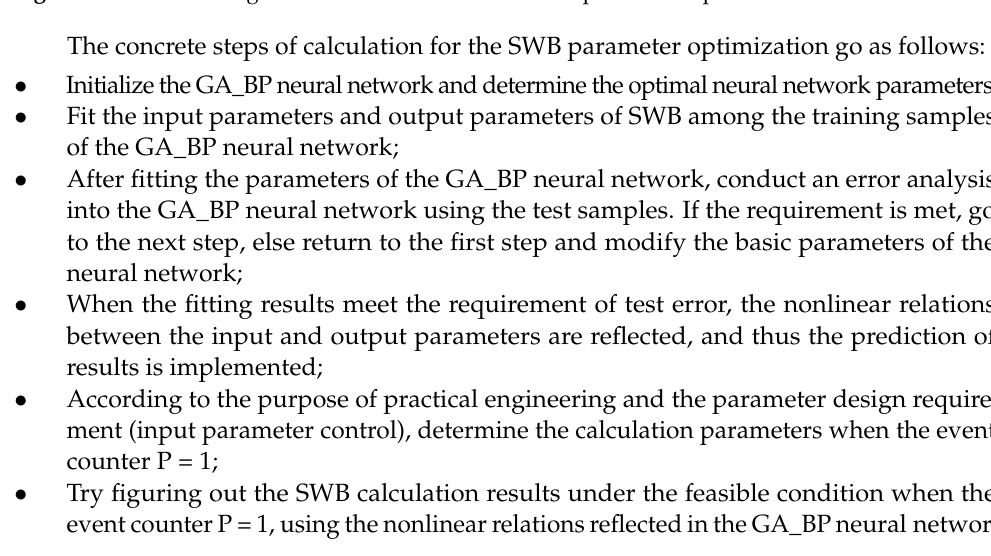
Figure 2. Schematic diagram of the calculation model for parameter optimization.